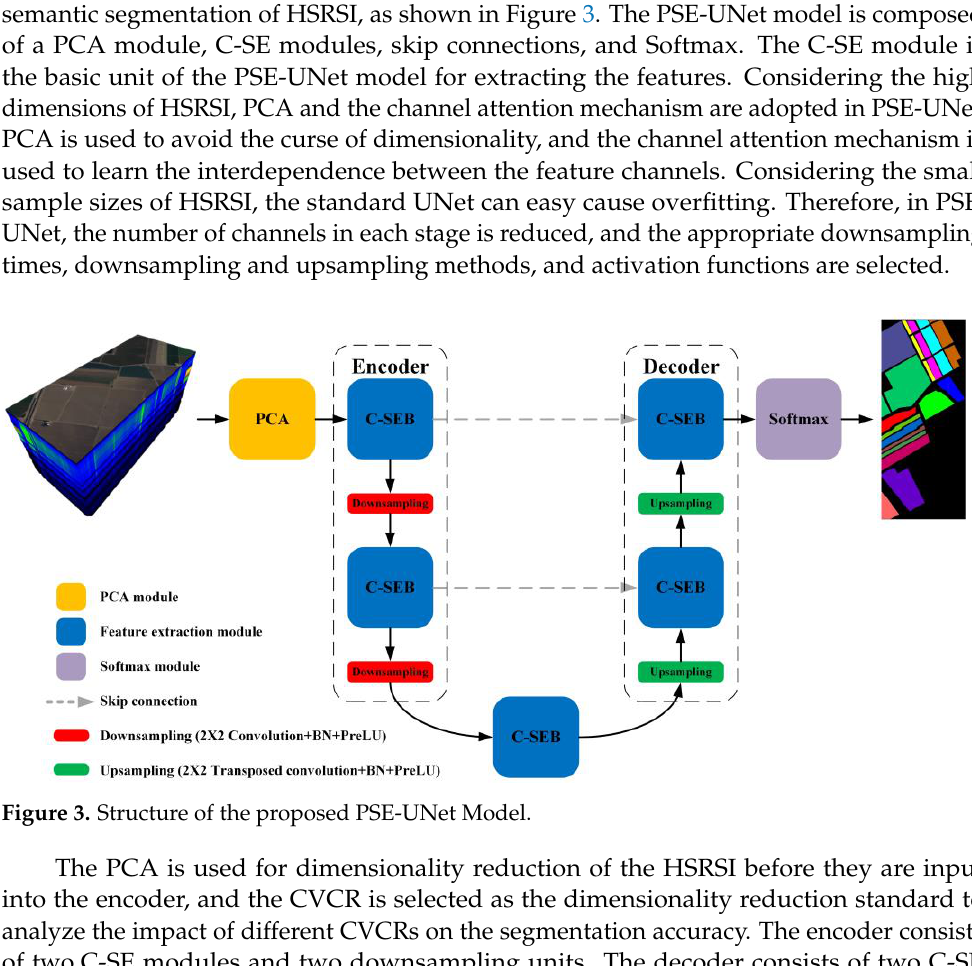
Figure 2. Dataset partition method.